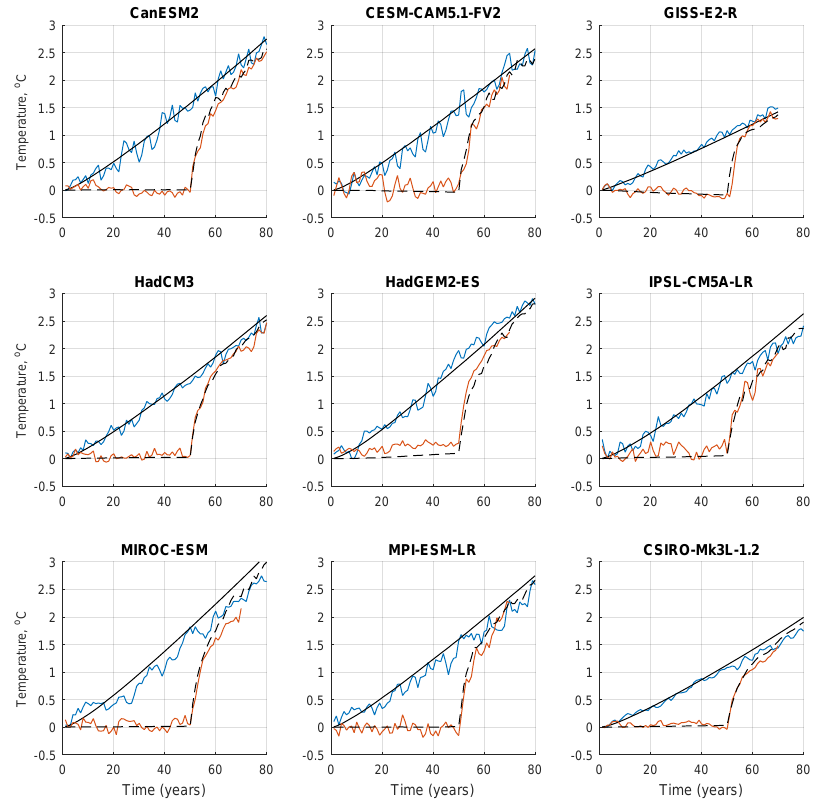
Figure 3. Simulated and predicted global-mean temperature, both for a 1% per year increase in CO 2 (blue curves) and for GeoMIP exper- iment G2 (red), for each of the climate models considered here. The predicted response using the emulator is given by black lines, solid for the 1% CO 2 case and dashed for